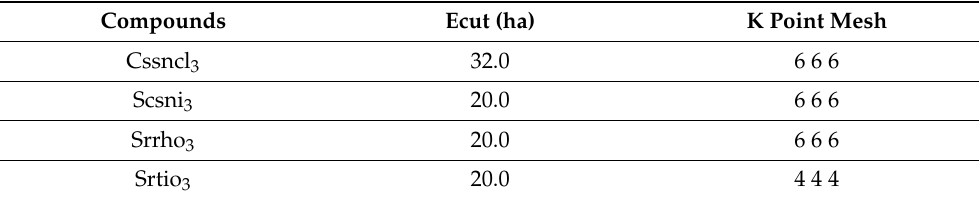
Table 3. Kinetic energy cut off (ecut), k-point mesh convergence for cubic perovskites.